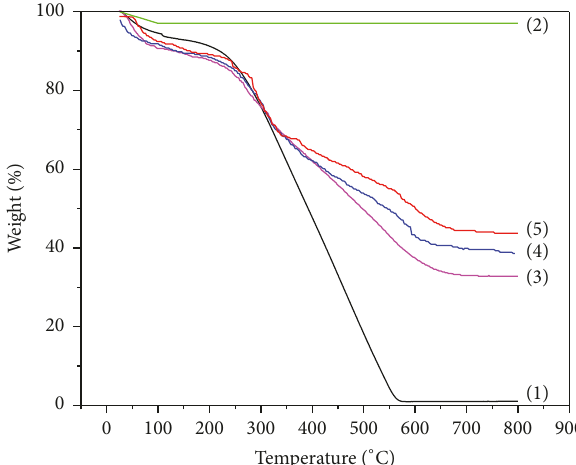
Figure 4: TGA curves of (1) PPy, (2) SiO 2 , (3) SPO1, (4) SPO2, (5)